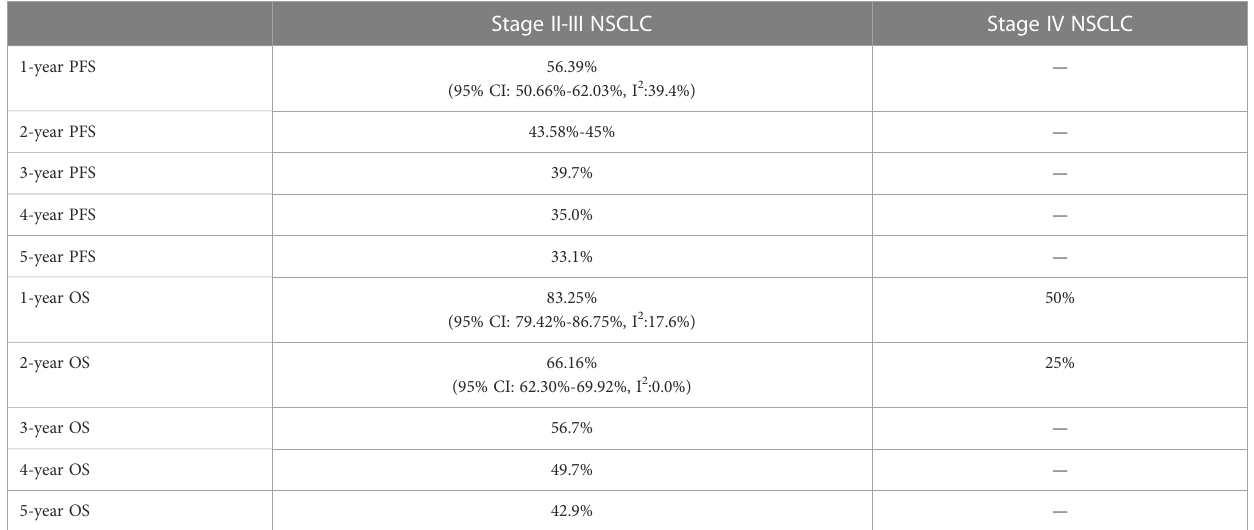
ICIs, Immune checkpoint inhibitors; RT, Radiotherapy; PFS, Progression Free Survival; OS, Overall Survival; NSCLC, non-small cell lung